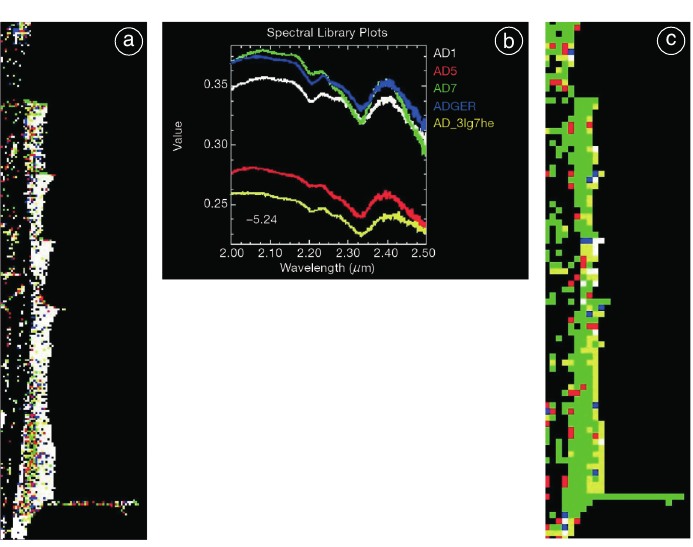
Fig. 2a-c. a) SAM classification of the image of fig.1a, with 3 m ground resolution; b) endmember library: white, green and blue: >90% of light mineral fraction; composition: quartz, dolomite, calcite, feldspars, micas; the spectrum coded white has the lowest carbonate content; red and yellow: about 70% of heavy mineral frac- tion; composition: quartz, dolomite, calcite, hornblende, clinopyroxene, muscovite, biotite, feldspars; c) SAM classification of the same image, with a degraded ground resolution of 9